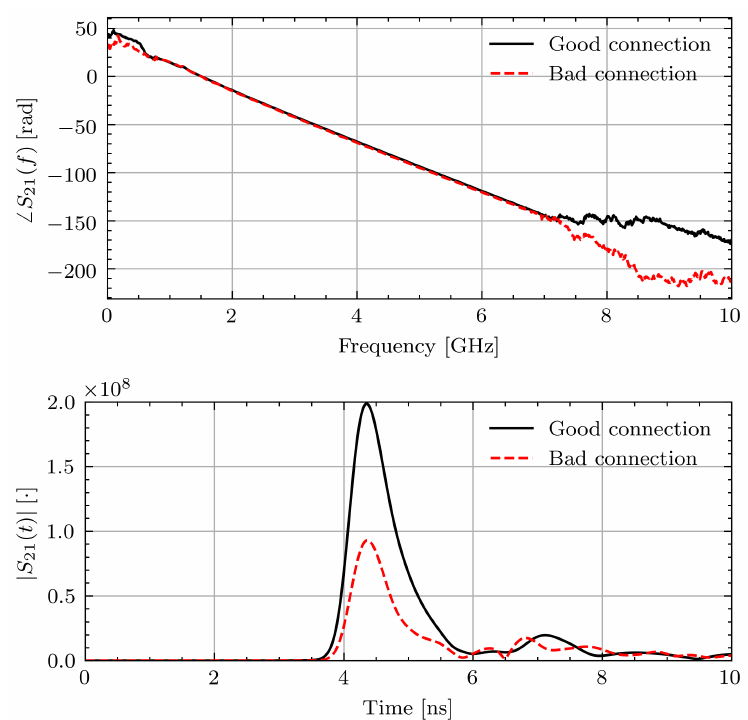
Figure 5. Measured ∠ S 21 ( f ) and | S 21 ( t ) | signals through water with and without connection issue. To control for the connection issue, only signals that have a similar connection quality are compared on each day. To quantify the connection issue in the measurement data, the S 11 ( f ) signals below the frequency at which the antenna operates effectively, 1.2 GHz, can be used because the effect of the object under test will be minimal. As indicated by the frequency-dependent reflection coefficient in Figure 6, most of the power is reflected below 1.2 GHz. The connection issue impacts the reflection at these frequencies by changing the impedance at the antenna and cable